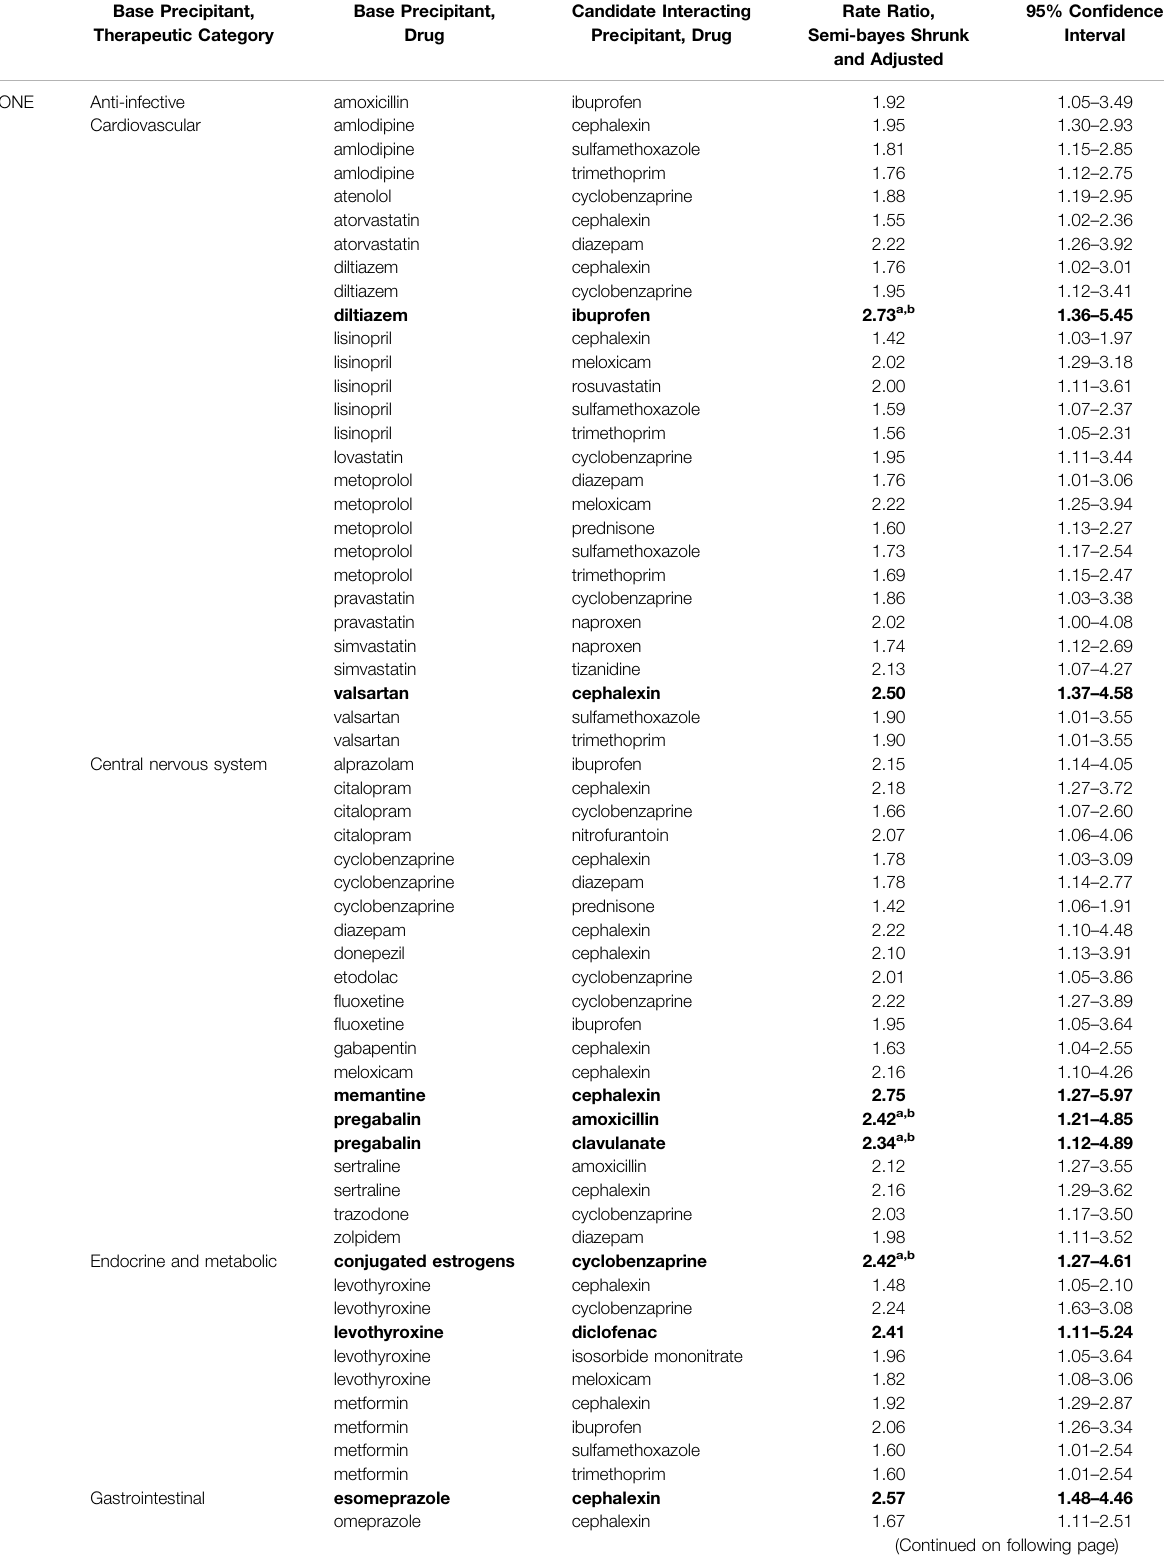
TABLE 3 | Drug-drug-drug interaction signals with statistically signi fi cantly increased rates of unintentional traumatic injury for commonly used opioids, by therapeutic category of base pair precipitant drug.